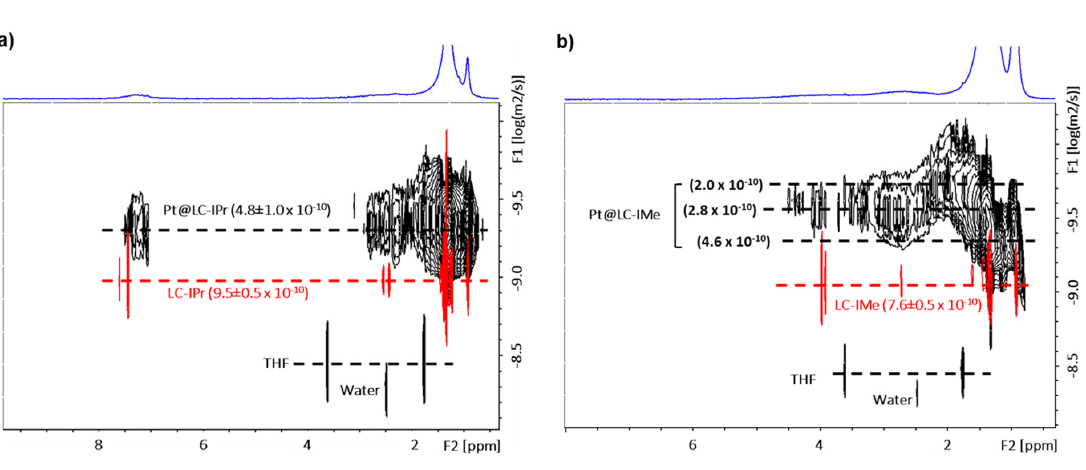
Figure 15. 1 H DOSY spectra of Pt / LC-IPr (black, ( a )) and Pt / LC-IMe (black, ( b )), together with their corresponding carbene precursors LC-IPr · HBr (red, ( a )) and LC-IMe · HI (red, ( b )) in THF-d 8 . Extracted with permission from reference 23. Copyright 2017 Willey ‐ VCH.